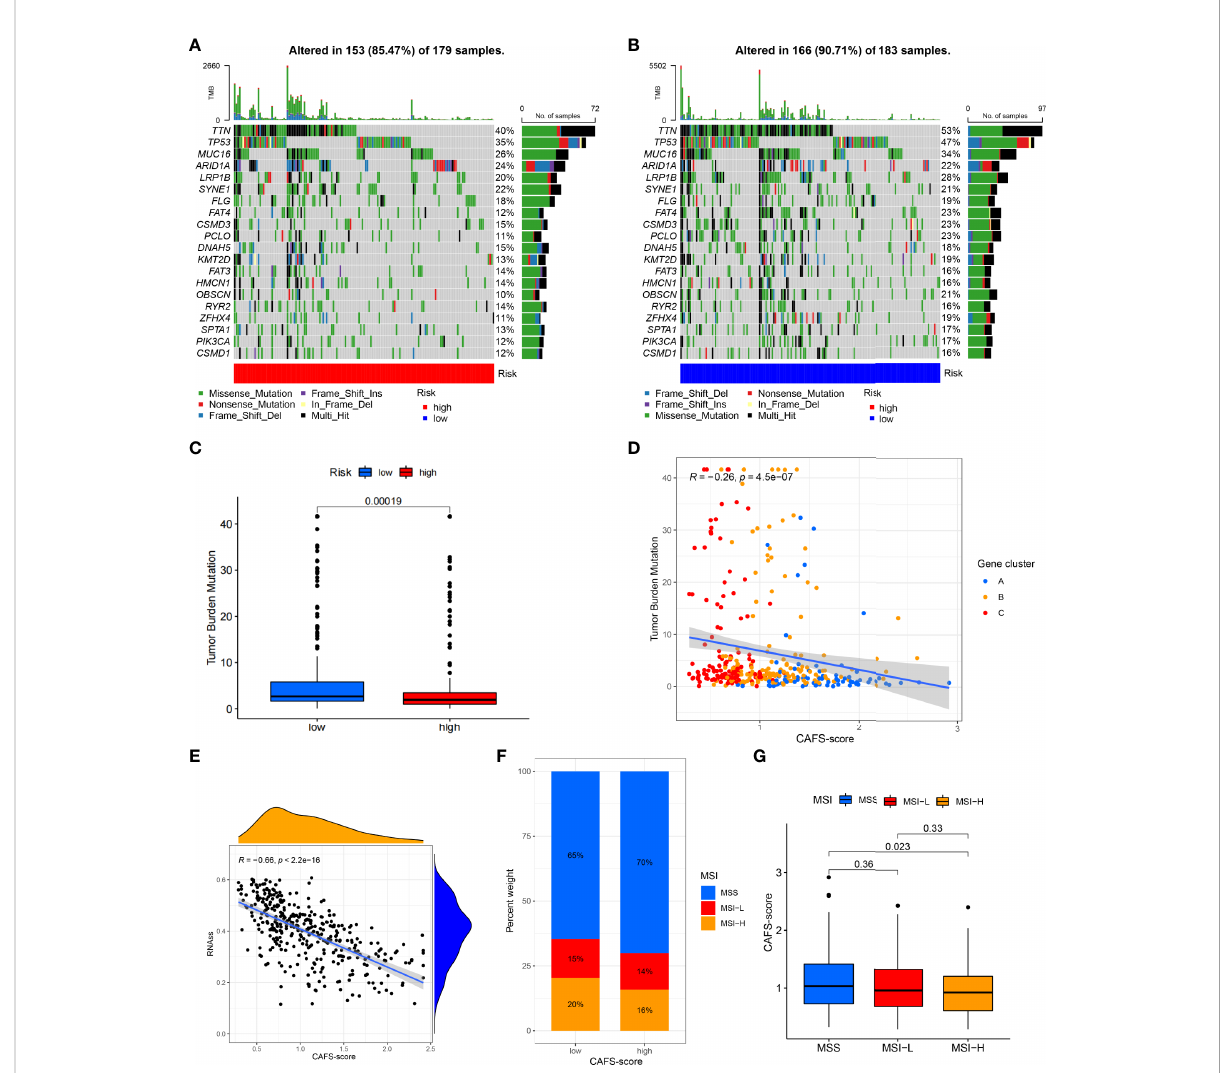
FIGURE 6 Characteristic in gene mutation and relationship of CAFS-score with MSI and CSC index. (A, B) Signi fi cantly mutated genes in the mutated GC samples of the high and the low risk groups, respectively. Mutated genes (rows, top 20) are ordered by mutation rate; samples (columns) are arranged to emphasize mutual exclusivity among mutations. The right shows mutation percentage, and the top shows the overall number of mutations. The color-coding indicates the mutation type. (C) The TMB of two differen risk subgroups. (D) Relationships between CAFS-score and TMR in three gene subtypes. (E) Relationships between CAFS-score and CSC index. (F, G) Relationships between CAFS-score and